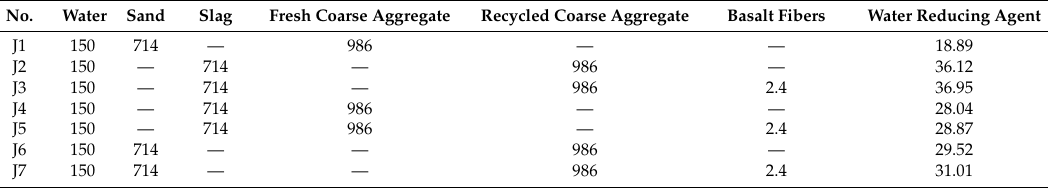
Table 5. Aggregate detail sheet (kg / m 3